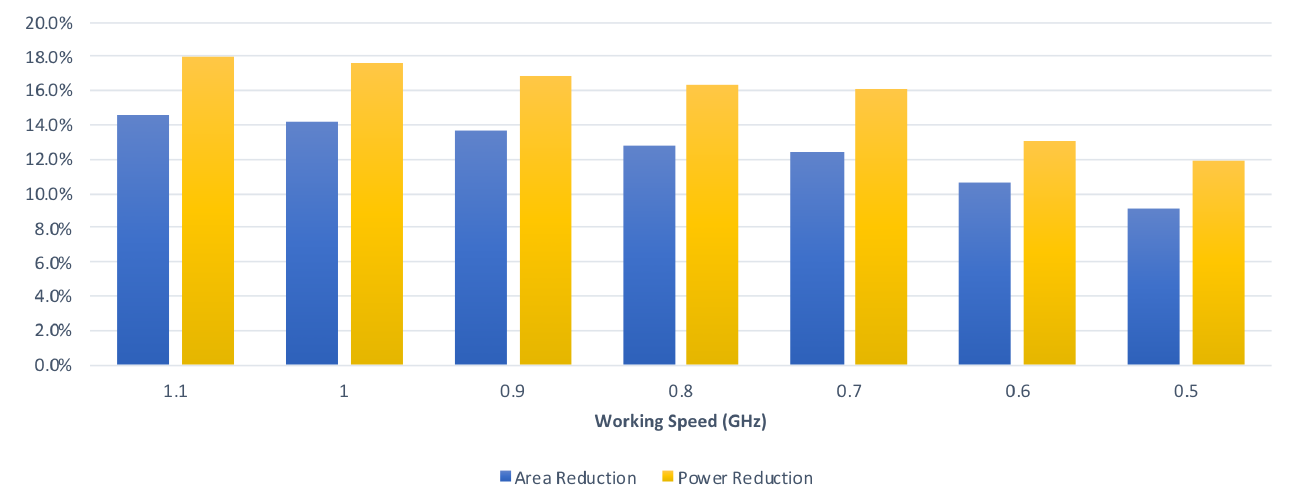
Figure 21. The reduction rates of the proposed CA-O design under different timing